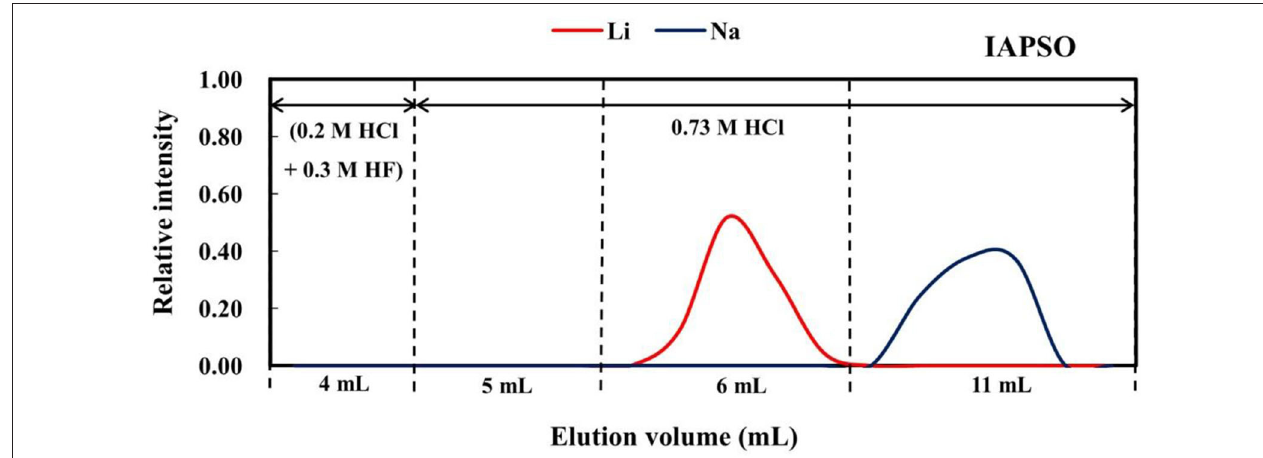
FIGURE 2 | Elution curve for seawater (IAPSO) on AGMP-50 resin.